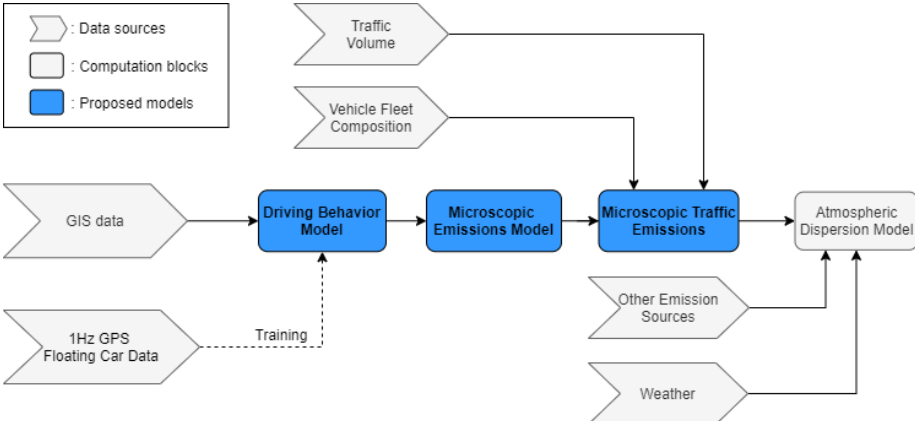
Figure 1. Illustration of the overall approach to translate macroscopic road information into road traffic environmental impact. This work focuses on the central blocks computing the microscopic vehicle emissions from only macroscopic available